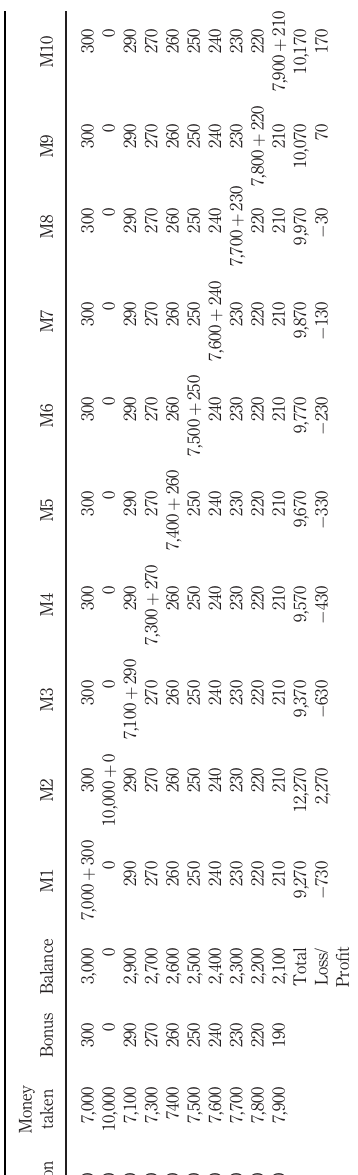
Table 13 January 2016